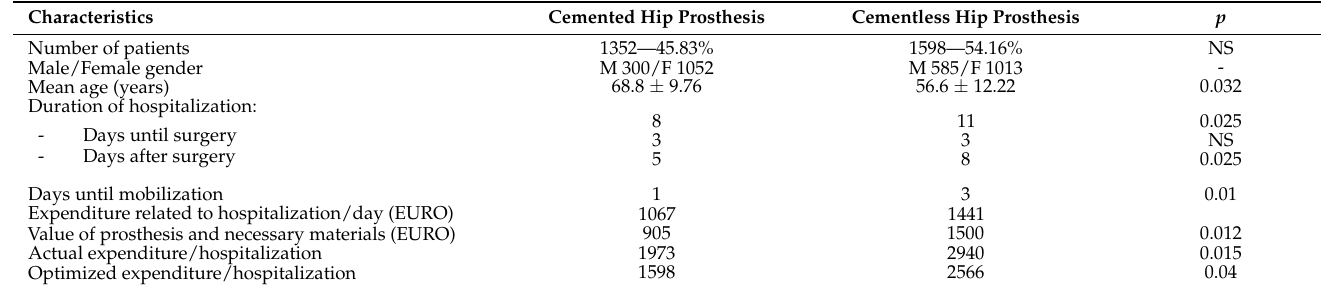
Table 2. Characteristics of patients, duration of hospitalization, and expenditure of hip